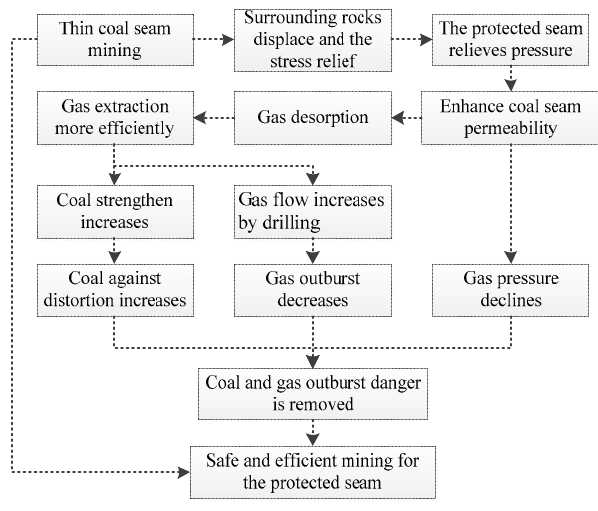
Figure 4. The protected seam stress relief induced by protective seam mining.